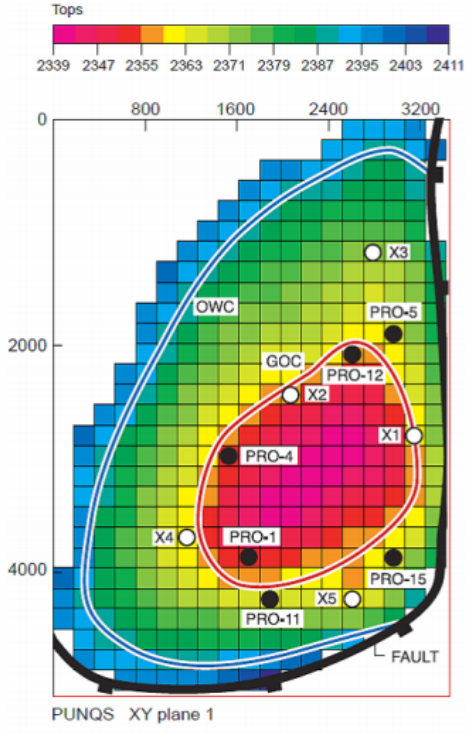
Figure 5. The top structure of PUNQ-S3 with